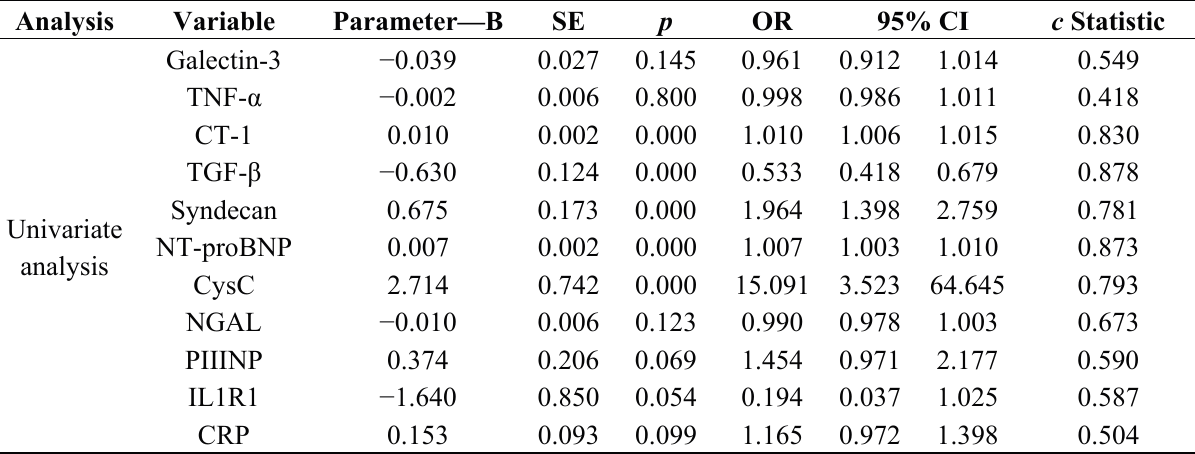
Table 4. Biomarkers with statistically significant diagnostic value for heart failure in univariate analysis.